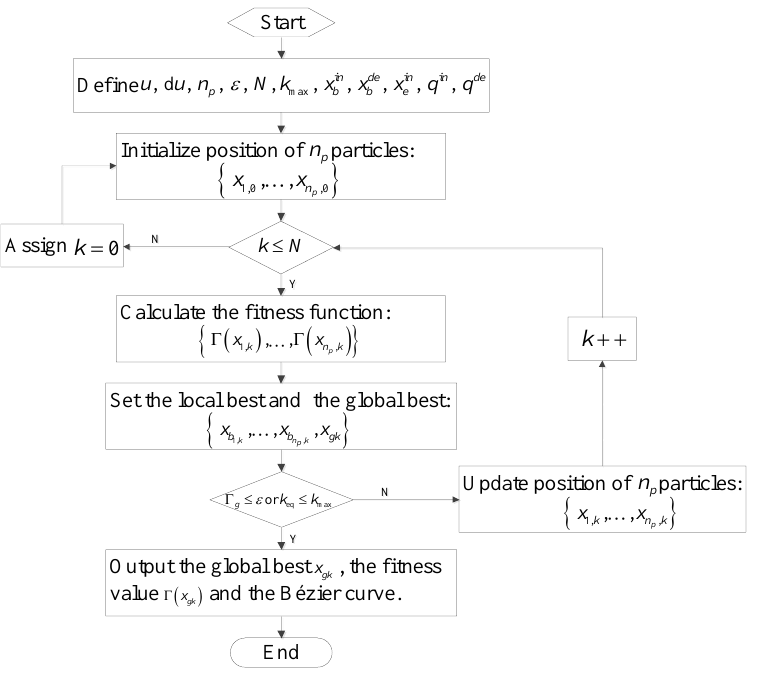
Figure 4. Flow chart of HPSO with self-adaptive ability for AEROM trajectory planning.